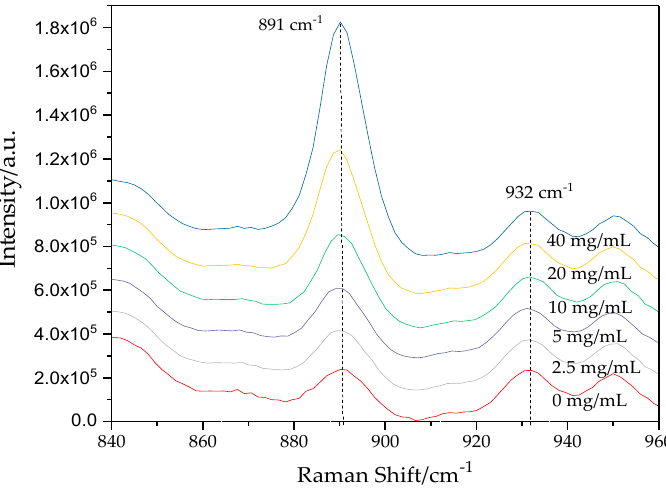
Figure 8. Raman spectra of oil-dissolved acetic acid samples at different concentrations.